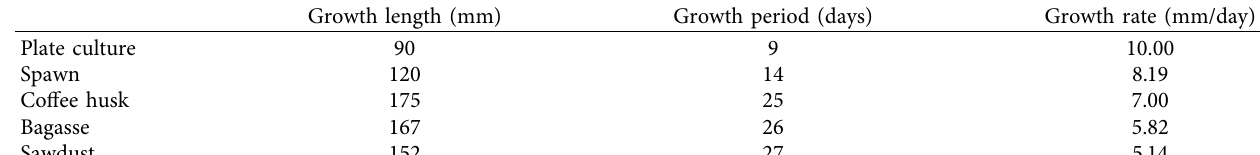
Table 1: Growth features of mycelium grown on PDA and different substrates.